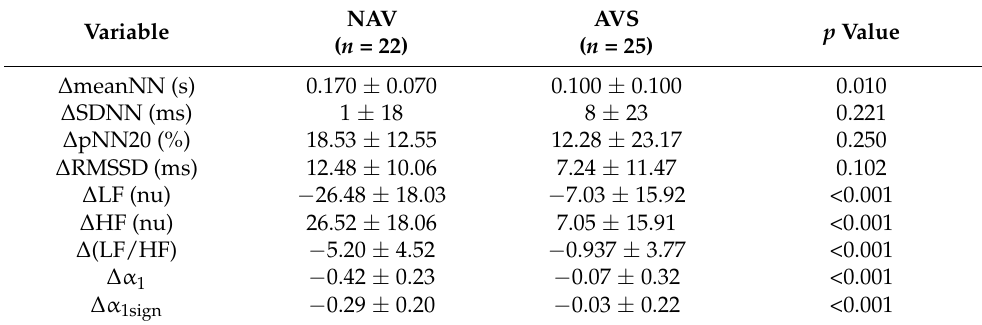
Table 5. Magnitude ( ∆ ) of change in heart rate variability indices in response to active standing. Data are shown as mean ± standard deviation and were compared between groups by a student t -test for independent groups. NAV AVS p Value Variable ( n = 22) ( n = 25) ∆ meanNN (s) 0.170 ± 0.070 0.100 ± 0.100 0.010 ∆ SDNN (ms) 1 ± 18 8 ± 23 0.221 ∆ pNN20 (%) 18.53 ± 12.55 12.28 ± 23.17 0.250 ∆ RMSSD (ms) 12.48 ± 10.06 7.24 ±